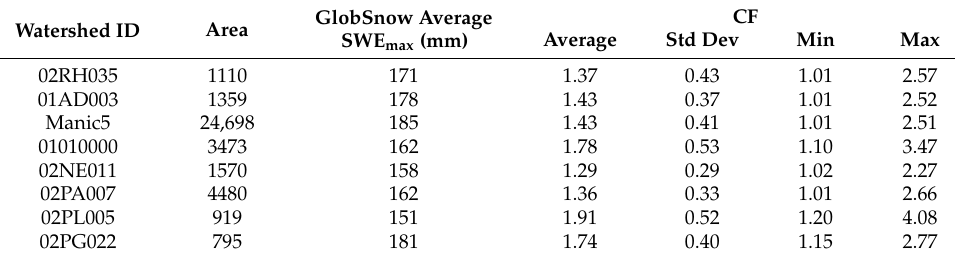
Figure 5. CF values of Manic5 ( a ), 02RH035 ( b ) an 01AD003 ( c ) watersheds. For each watershed, upper left graph shows the direct runoff hydrograph (DRH) in blue, watershed infiltration (I) in purple, and maximum snow water equivalent from GlobSnow ( SWE max Glob ) in green. Lower left graph shows the resulting CF values. Values lower than 1 are discarded. The graph to the right shows the sorted CF values ranked from lowest to largest. The average CF value is shown as the dotted line. In this figure, baseflow was estimated using β = 0.925. Table 3. Computed CF values for all watersheds under study.